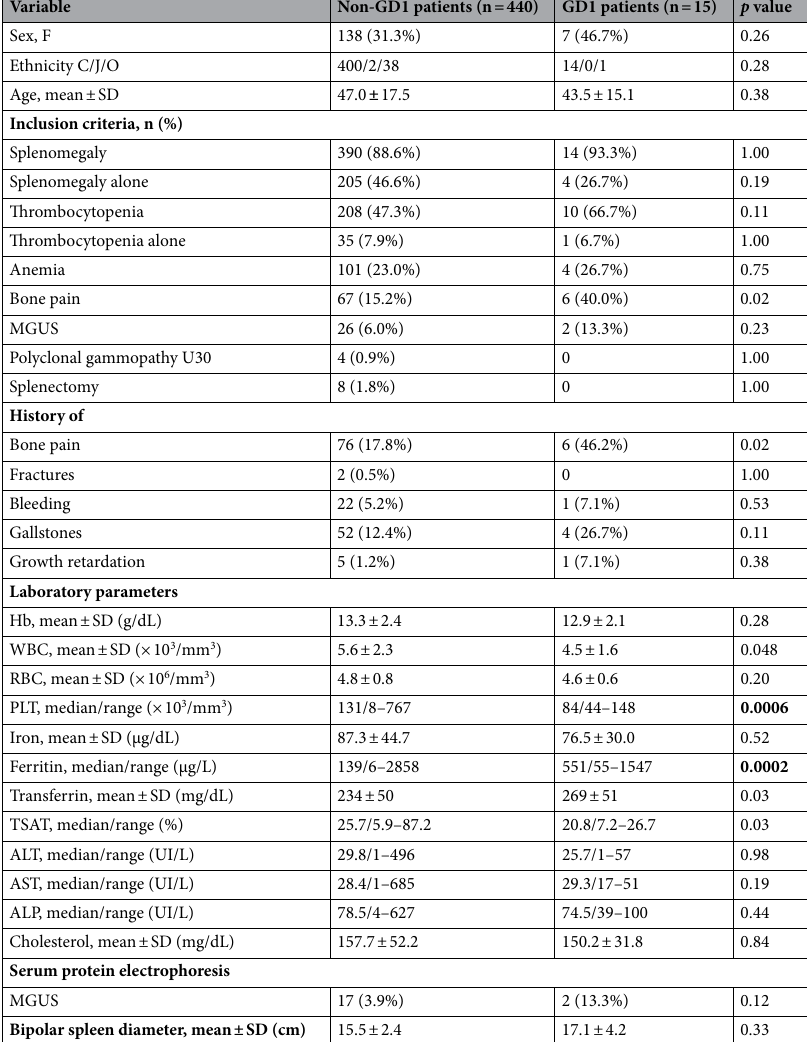
Table 1. Demographic, clinical, and laboratory characteristics. GD1: Gaucher disease type 1; C: Caucasian; J: Jewish; O: other; MGUS: monoclonal gammopathy of unknown significance; U30: under 30 years of age;